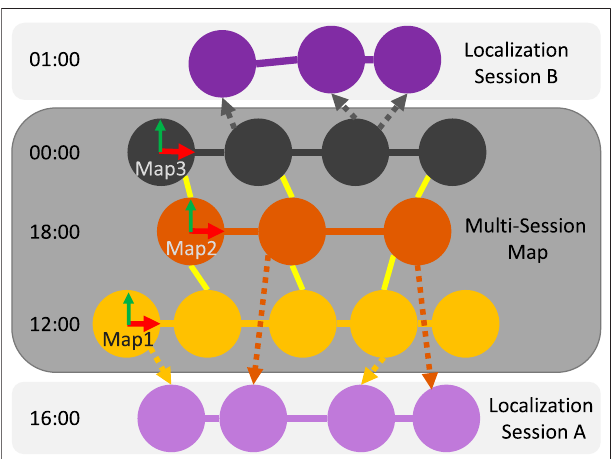
FIGURE 1 | Structure of the multi-session map. Three sessions taken at different times have been merged together during the SLAM phase by fi nding loop closures between them (yellow links). Each map has its own coordinate frame. During the localization-only phase, Localization Session A (16:00) is re-localized in relation to both day sessions in the map (12:00 and 18:00), and Localization Session B (01:00) is only re-localized on the night session